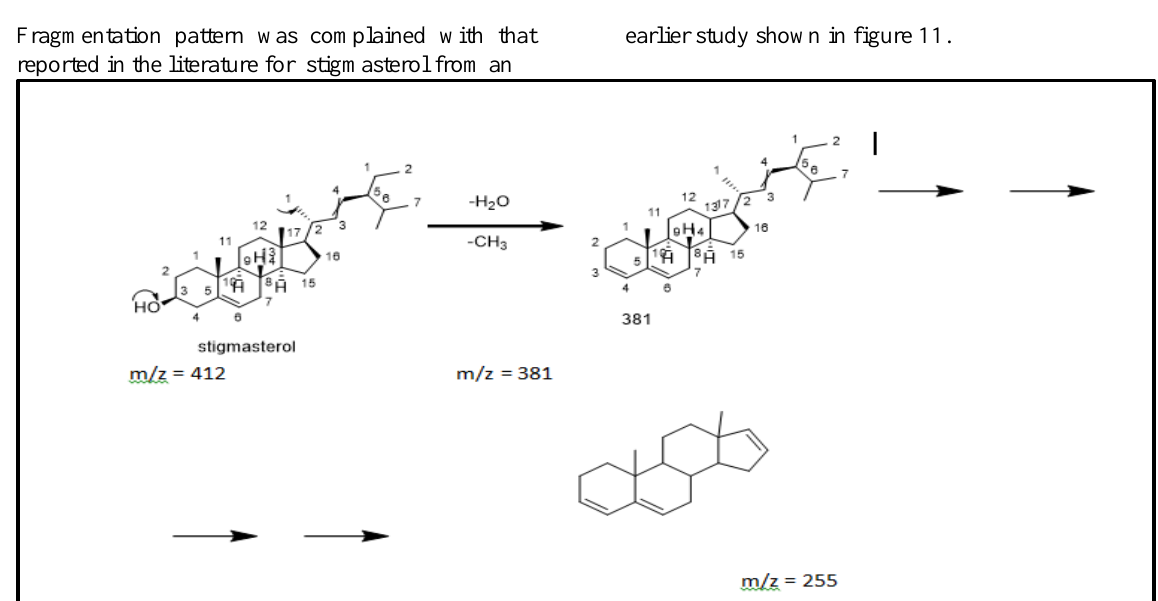
Figure 11: molecular ion and fragments of stigmasterol in hexane fraction (22) . B- LC/MS for the isolated rutin confirmed the structure of the isolated rutin since fragmentation